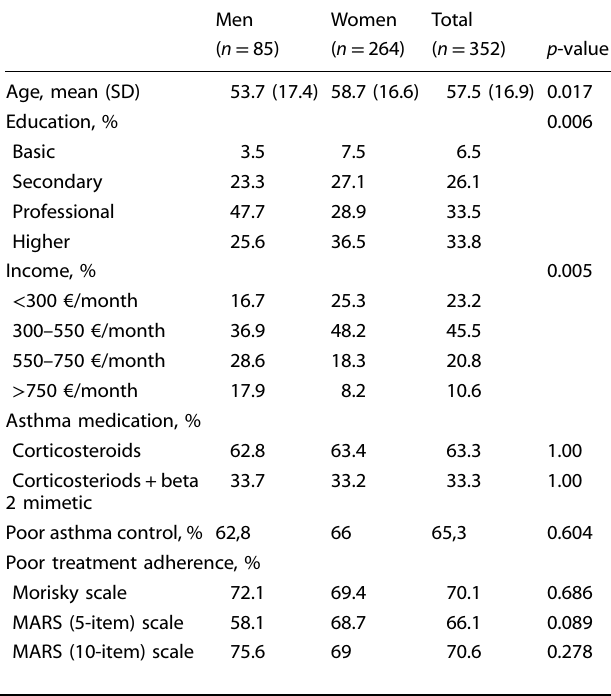
Table 1. Baseline characteristics of the study sample Table 2. Associations of different asthma medication